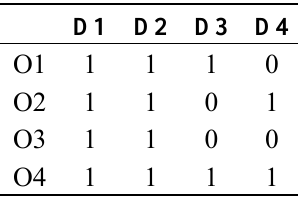
Table 4. Matrix representing a stimulus set structure with four object-stimuli O1–O4 of four dimensions